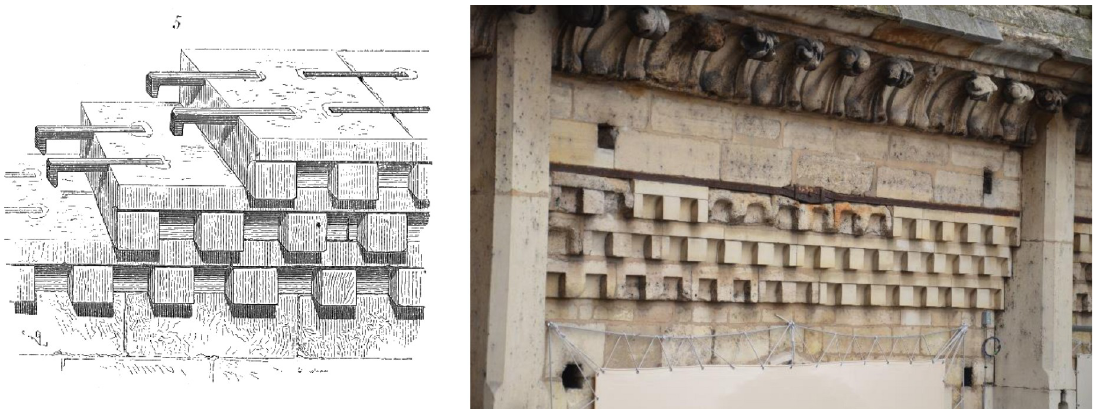
Fig 3. View of the checked cornice of the choir with its series of staples drawn by Viollet-le-Duc (left) [19 tome 2, p. 400] and today, with the chains implemented by Lassus (right).